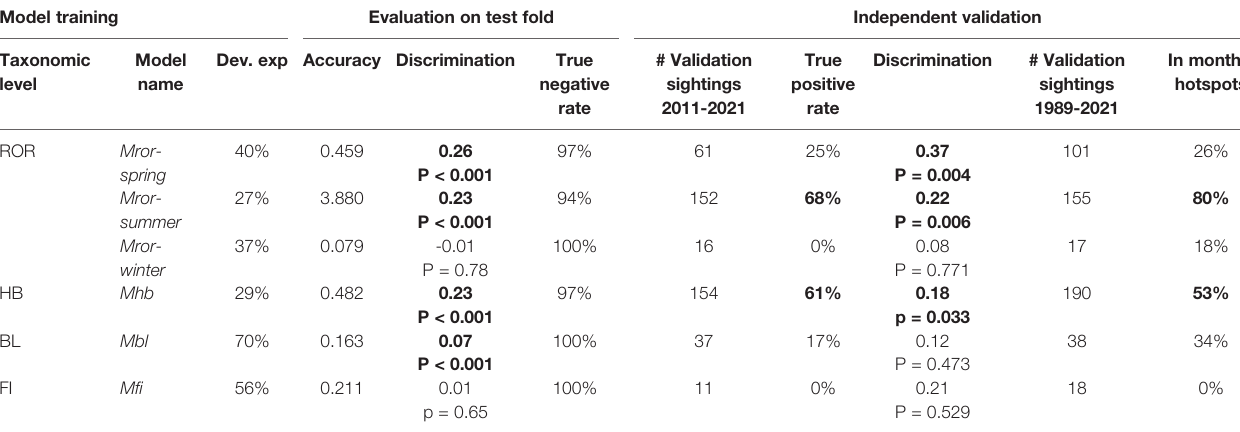
TABLE 2 | Summary of the species density models for rorquals (ROR), humpback whales (HB), blue whales (BL) and fi n whales (FI). Model training